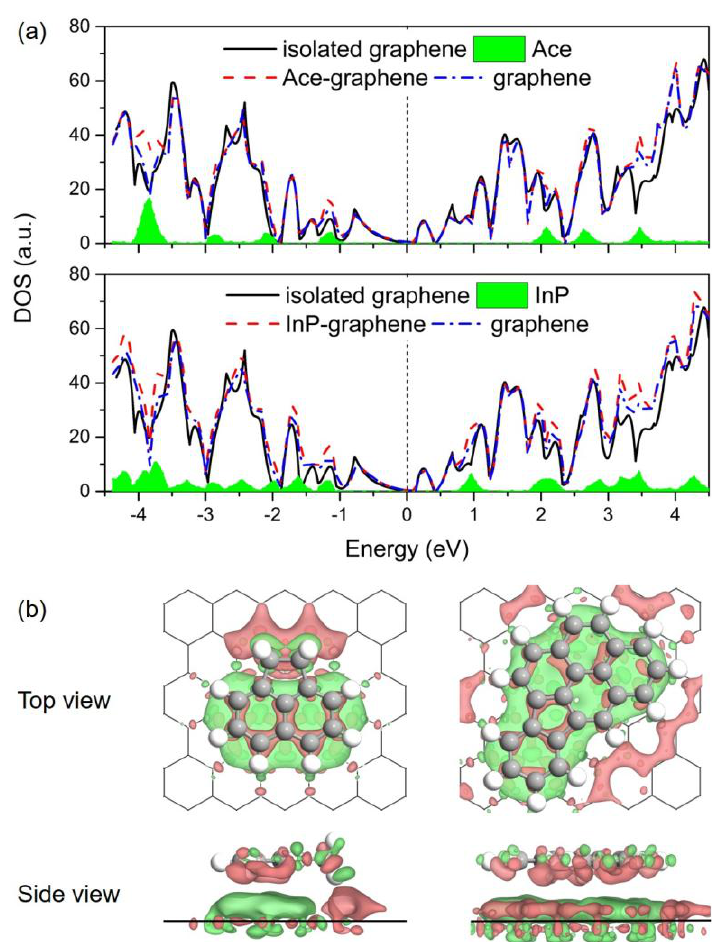
Figure 5. ( a ) Calculated density of states (DOS) for Ace/Gr (up) and InP/Gr (down) systems. The Fermi level was set as zero; ( b ) Differential electron density (Δ ρ ) for Ace/Gr (left) and InP/Gr (right) adsorption systems. Isosurface contours of electron density differences are drawn at ±0.001 e/Bohr 3 . The electron accumulation and depletion are depicted in red and green colors, respectively.